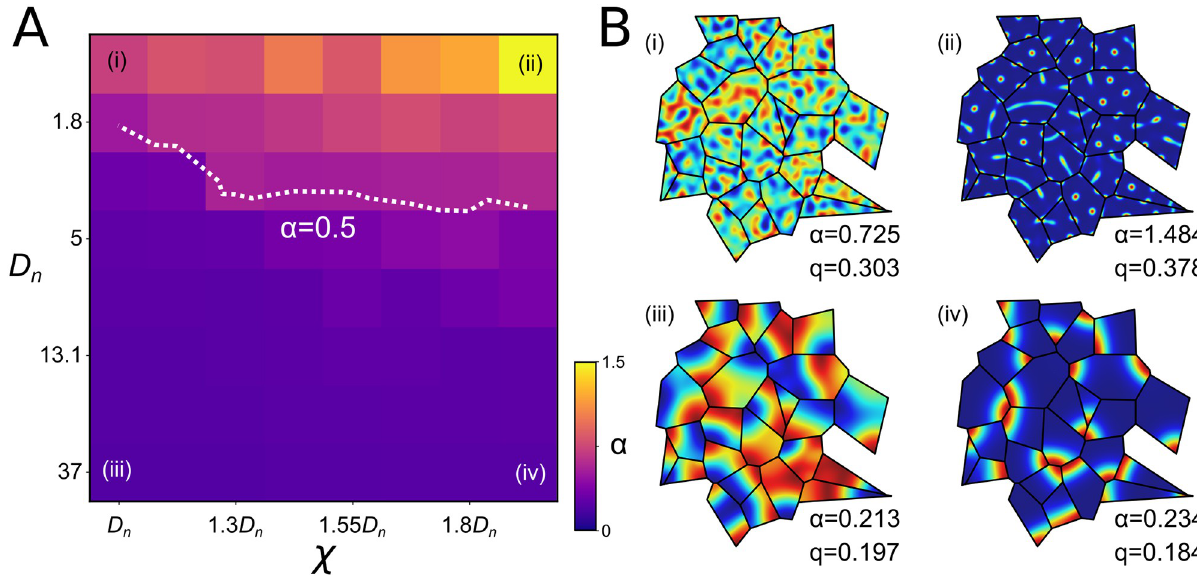
Fig 5. Correlated pattern formation in tessellated domains is predicted to emerge robustly across a wide range of pattern-forming systems. Correlations between self-organized patterns in adjacent domains of randomly seeded Voronoi tessellations were measured across a wide range of parameters. Panel A shows values of α estimated from the distribution of 1000 pairwise correlation coefficients obtained from each of sixty four combinations of parameter values (as in Fig 4A; ‘constrained’). The overlaid contour corresponds to the threshold, α = 0.5, at or below which the hypothesis that the domain boundaries constrained pattern formation is very strongly supported. Based on this threshold, patterns are expected to be correlated by the tessellation boundary constraints across a large portion of the parameter space. Panel B shows example patterns for four extreme cases.